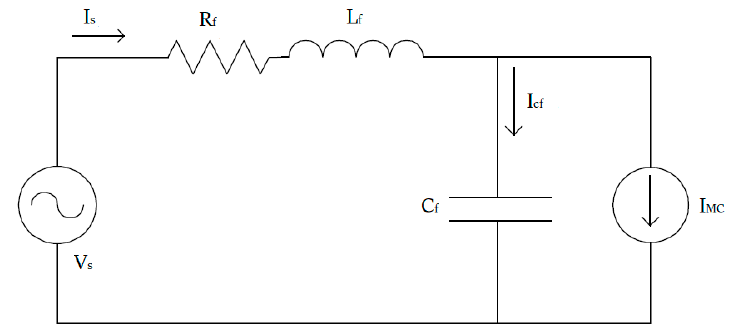
Figure 3. Equivalent model of the input filter circuit.